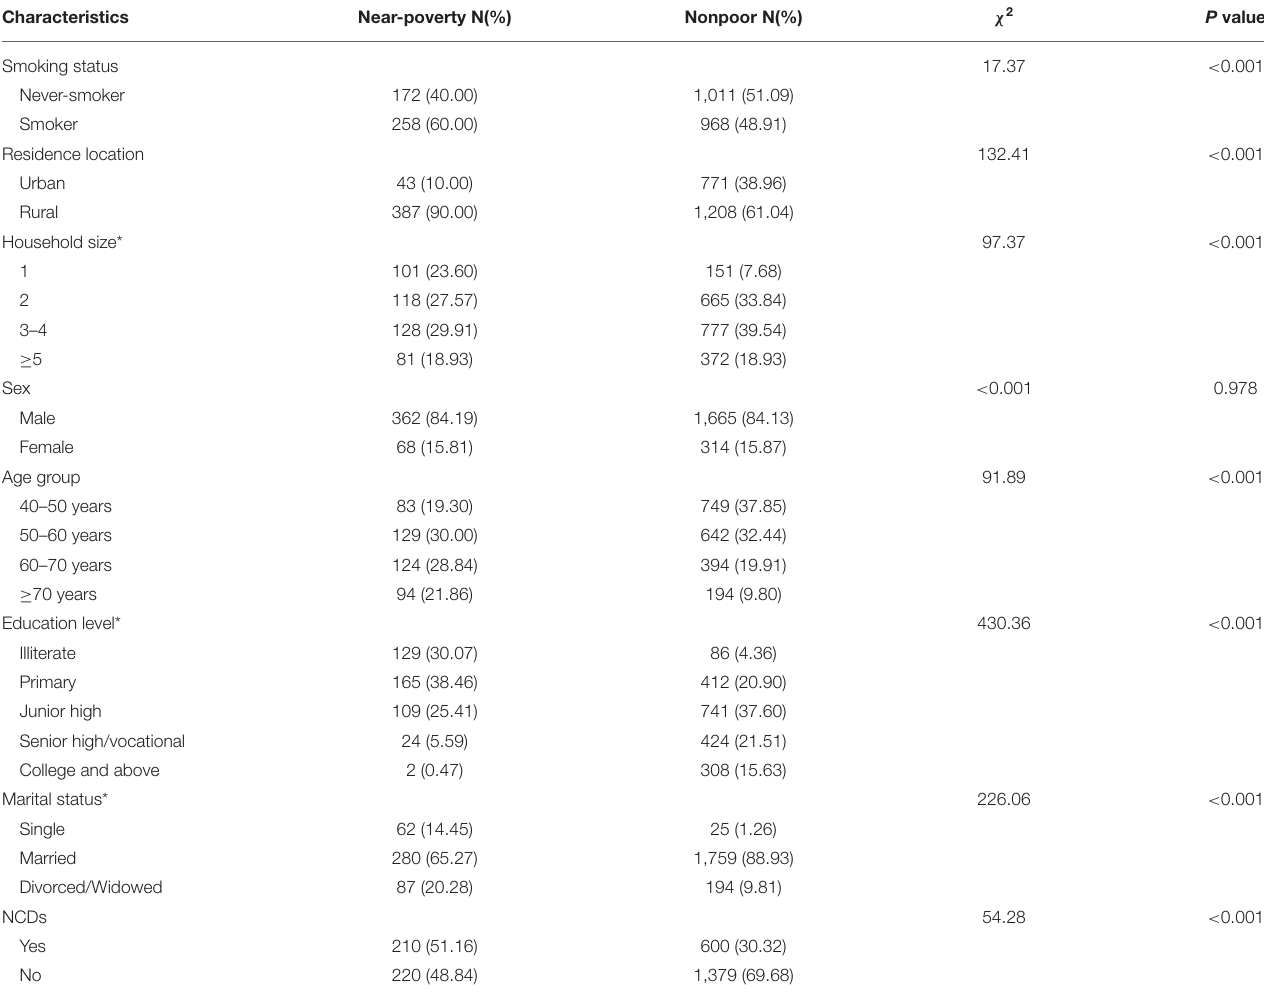
TABLE 1 | The sociodemographic characteristics of near-poverty and nonpoor households.